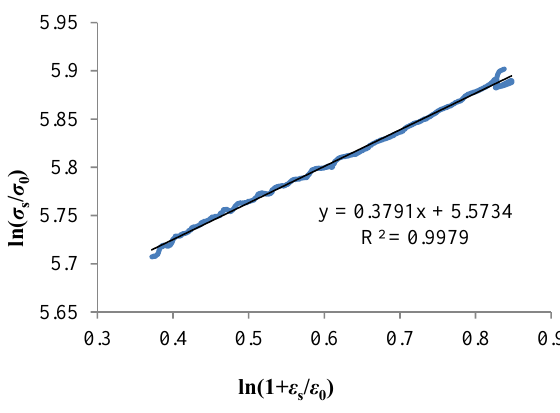
Figure 6. The relationship between ln( σ s / σ 0 ) and ln(1 + ε s / ε 0 ).